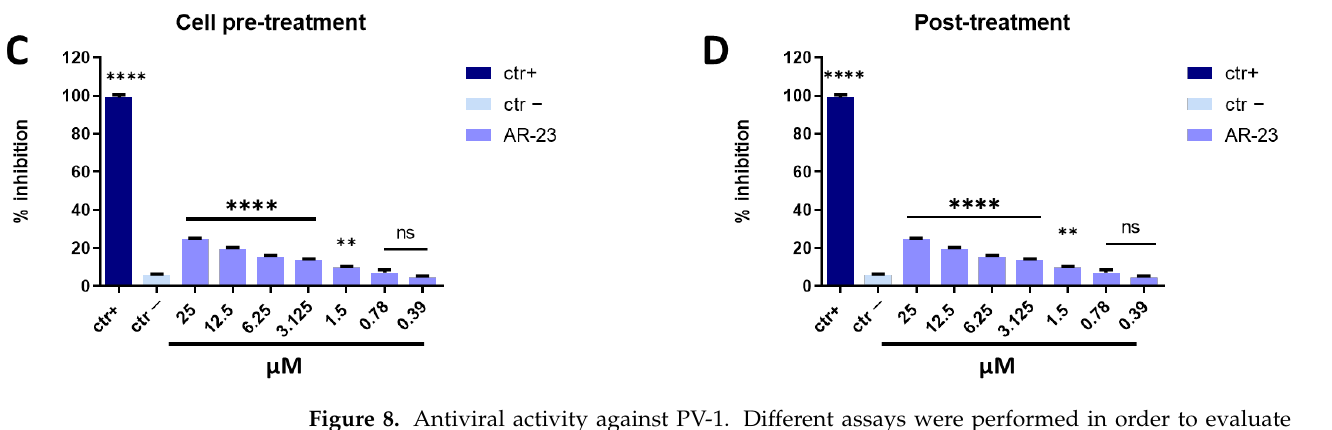
Figure 8. Antiviral activity against PV-1. Different assays were performed in order to evaluate anti-PV-1 activity. ( A ) Co-treatment: simultaneous addition of AR-23 and virus to the cells; ( B ) Virus pre-treatment: virus incubated with the peptide, and then used to infect cells; ( C ) Cell pre-treatment: AR-23 incubated with the cells before the viral infection; ( D ) Post-treatment: AR-23 added to the infected cells. Peptide AR-23 inhibited the early stages of infection, acting in co-treatment ( A ) and virus pre-treatment ( B ) assays, while it was not able to interact with the cellular surface ( C ) or block the viral replication ( D ). Different compounds were used as positive control (ctr+) for each treatment: pleconaril ( A , B , 2 µ g/mL for both the assays) [46], WIN51711 ( C , 5 µ g/mL) [45], and protein 2C (D, 10 µ M) [47], while infected cells were used as negative control (ctr-). **** p < 0.0001; ** p < 0.0021; * p < 0.021; ns: non-significant.